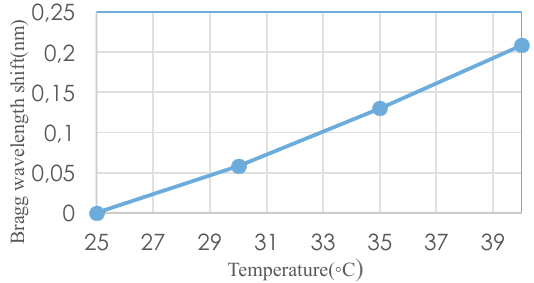
Figure 11: Undesirable Bragg wavelength shift (nm) versus temperature (°C).